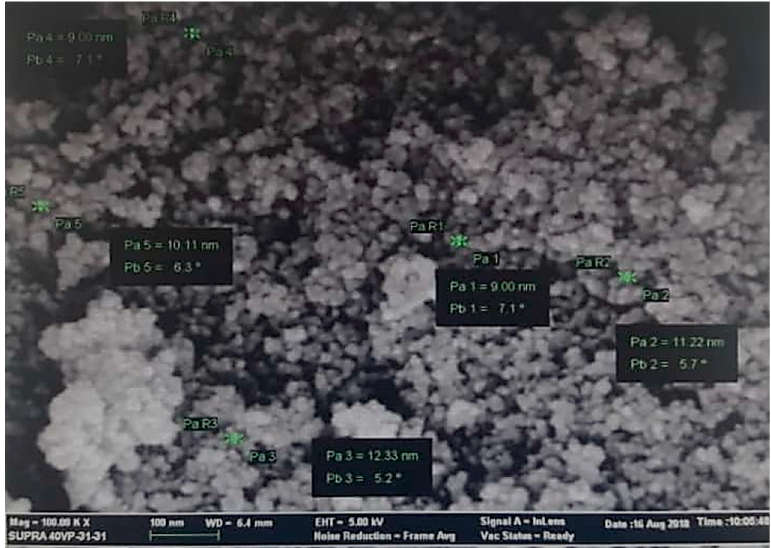
Figure 5. Field emission scanning electron microscopy (FESEM) micrograph of the biosynthesized iron oxide nanoparticles.